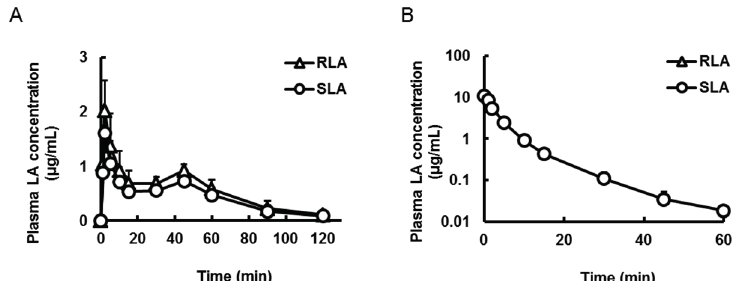
Figure 3. Plasma concentration-time profiles of α -lipoic acid after oral ( A ) and intravenous ( B ) administration of the racemic mixture. Data are shown as mean ± standard deviation ( n =